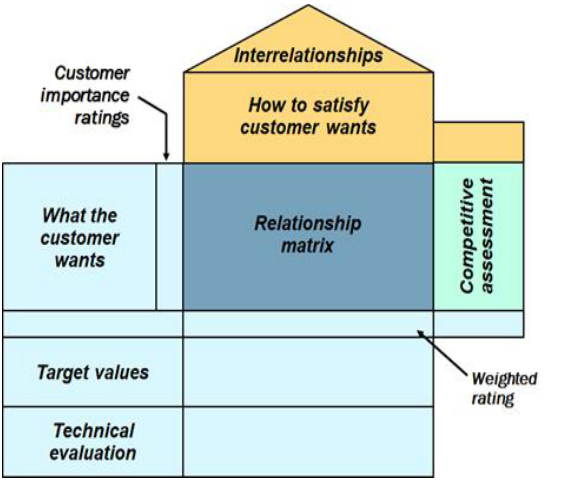
Figure 1. House of Quality